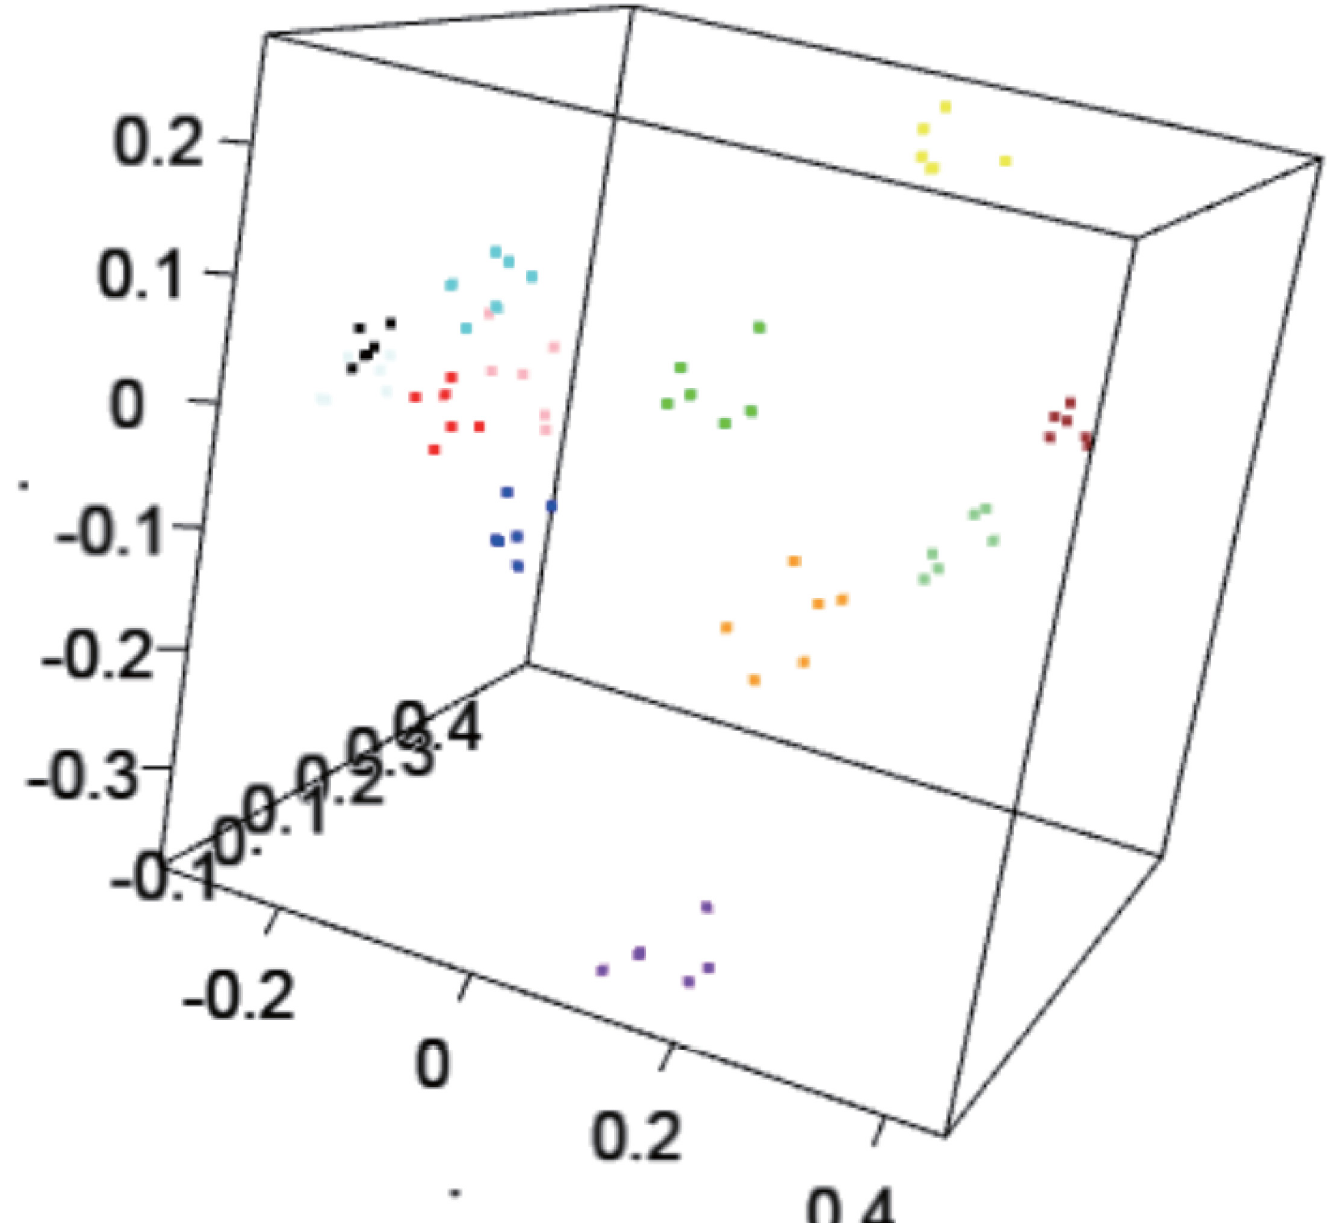
Fig 4. 3D plot resulting from principal coordinate analysis derived from 12 samples and the six different boiling methods. Dots with respective colors indicate they are from the same